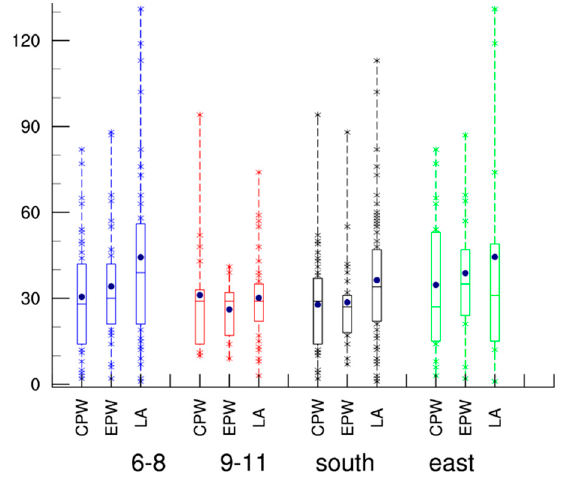
Figure 5. Same as in Figure 3, but for frequency (number) of TCs making landfall.